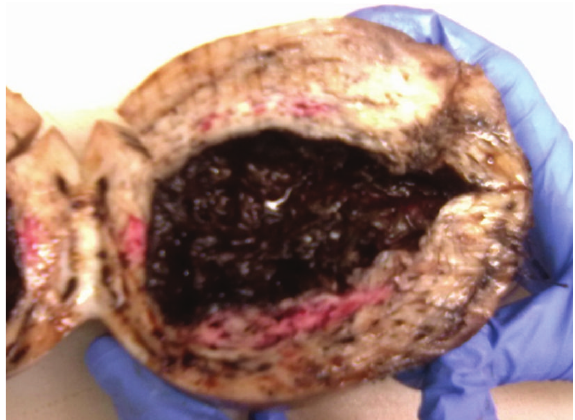
Figure 2: Transversal section of the rudimentary uterine horn, showing a cavity coated with decidualized